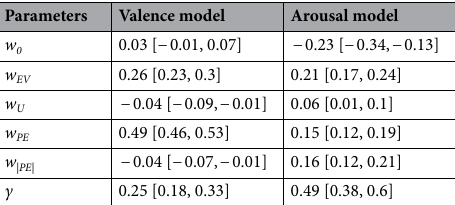
Table 1. The posterior distributions on parameter estimates showing the group level means of parameters. The ranges in parentheses represent 95% Highest density intervals